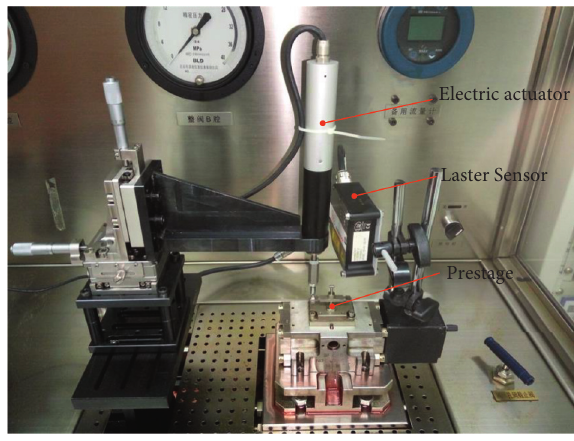
Figure 7: Experimental device of the jet deflector mechanism.